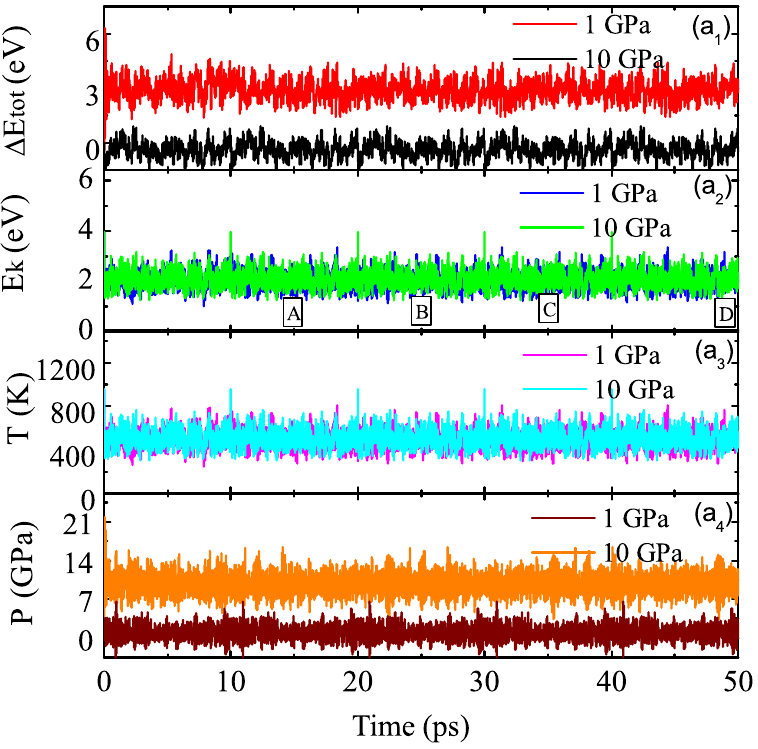
Figure 11. Molecular dynamics simulation was carried out for 8-Td-N 4 . Figure ( a 1 – a 4 ) show the total energy ( (cid:52) E tot (t) = E tot (t) − E tot (t 0 )), kinetic energy (E k ), temperature (T) and pressure (P) of the system as a function of time under 1 GPa and 10 GPa,